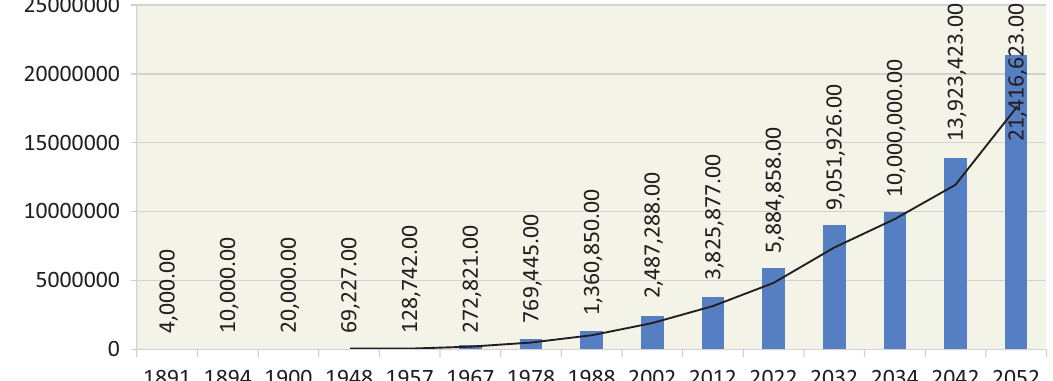
Figure 1. Population growth trend for Dar es Salaam city (1891–2052). Source: Sturgis